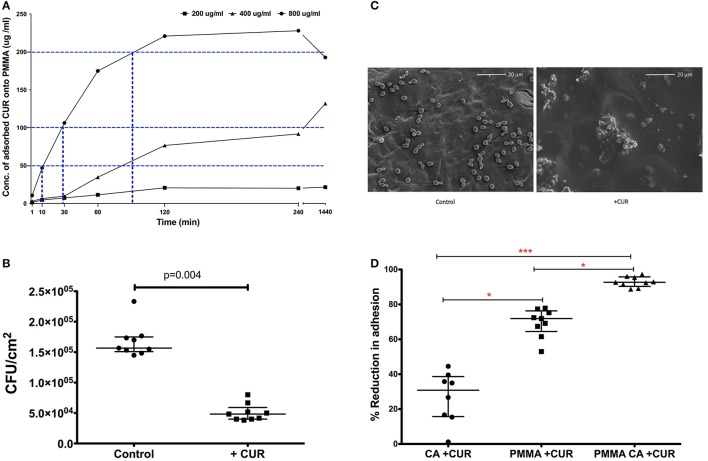
The impact of CUR adsorption to PMMA and its impact on Candida albicans SC5314 adhesion. (A) Time and concentration dependant adsorption of CUR to PMMA (blue dotted line) at half the MIC (50 μg/ml), MIC (100 μg/ml), and SMIC80 200 μg/ml. (B)
C. albicans inhibitory capability of 50 μg/ml adsorbed CUR onto PMMA compared to untreated control and a Mann–Whitney test was performed on data from nine independent experiments. (C) SEM images of 30 min adherent C. albicans cells onto CUR adsorbed (+CUR) and non-adsorbed PMMA control. (D) Single and dual-treatment of CUR on C. albicans adhesion, which were analyzed using a Kruskal–Wallis test with Dunn's multiple comparison post-test performed on data from nine independent experiments. All independant data points are presented, with error bars representing the median with interquartile range (*p < 0.05, **p < 0.01, ***p < 0.001).